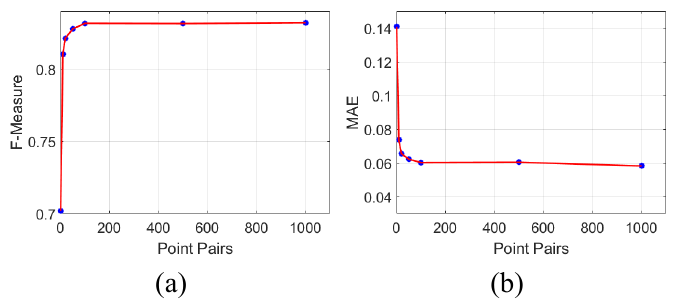
Figure 6. Ablation experiments on the amounts of sampled point pairs. Specifically, we sample {1, 10, 20 , 50, 100, 200, 500, 1000} point pairs per image. ( a ) F-measure; ( b ) MAE.